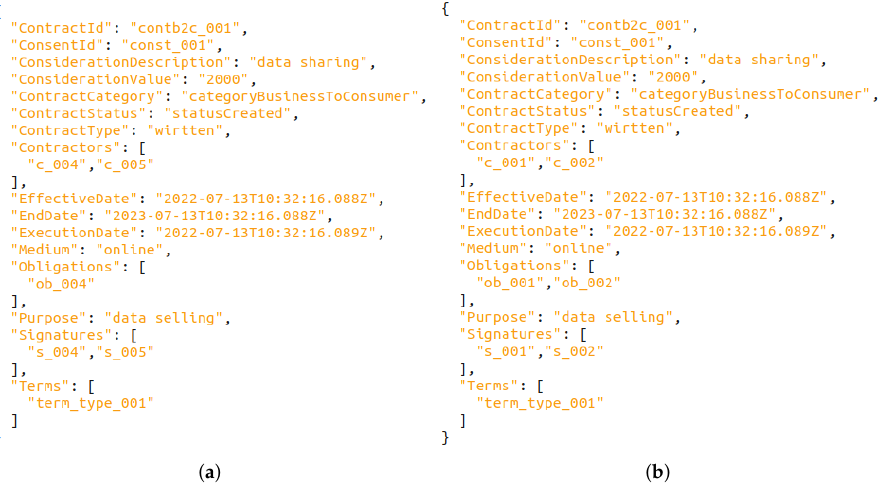
Figure 11. A snapshot of contract partial and full audit JSON Schema. ( a ) Partial audit. ( b ) Full